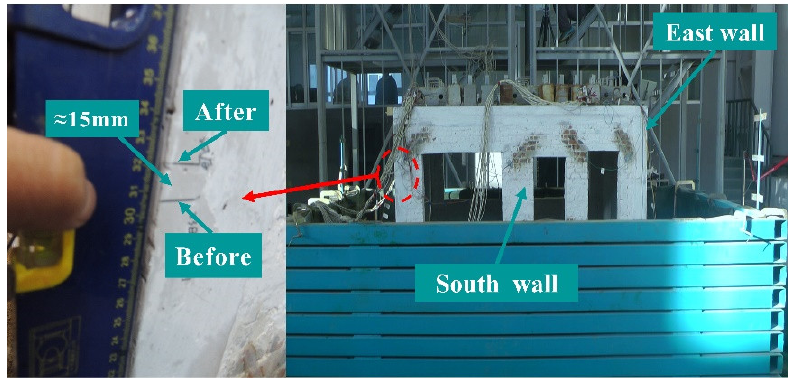
Figure 15. Settlement of models.